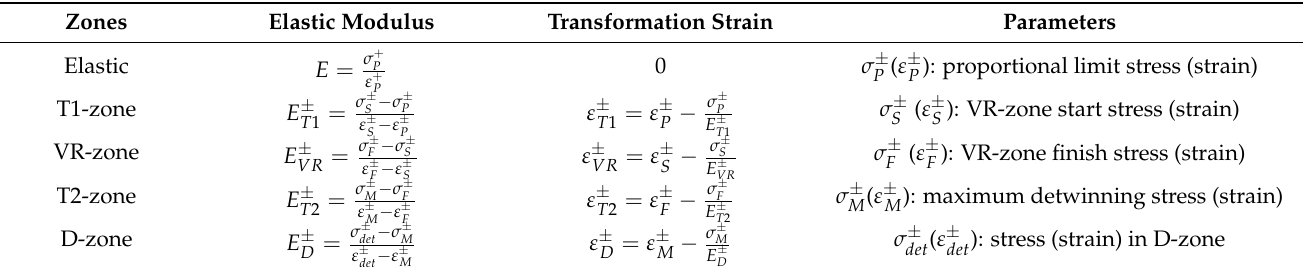
Table 2. Elastic modulus and transformation strain related to each